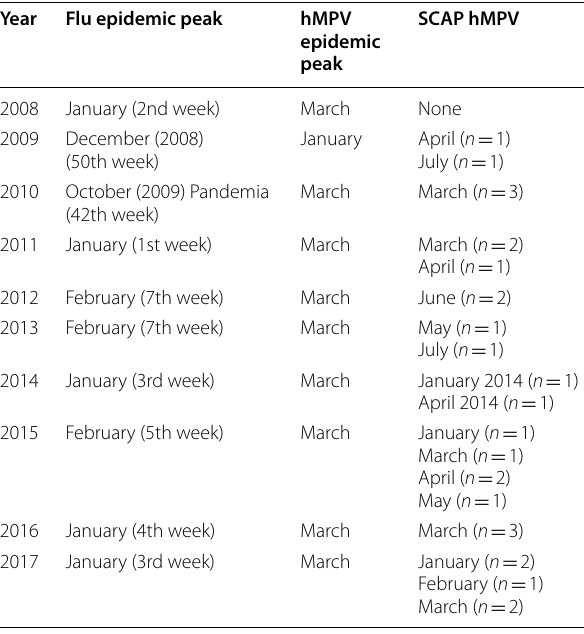
Table 1 Annual epidemic peaks of influenza virus and human metapneumovirus infections, and temporal distribution of isolates in patients with severe community-acquired pneumonia due to human metapneumovirus